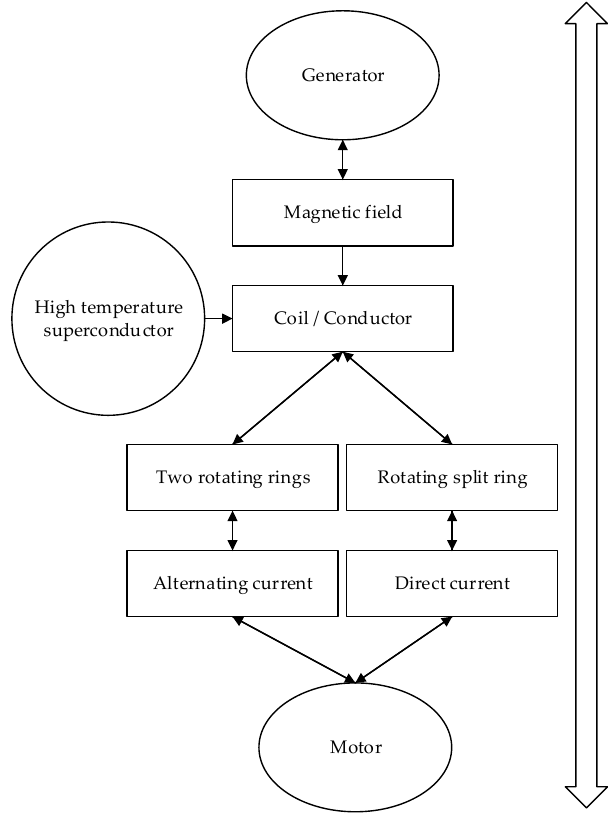
Figure 3. Generator model prototype.